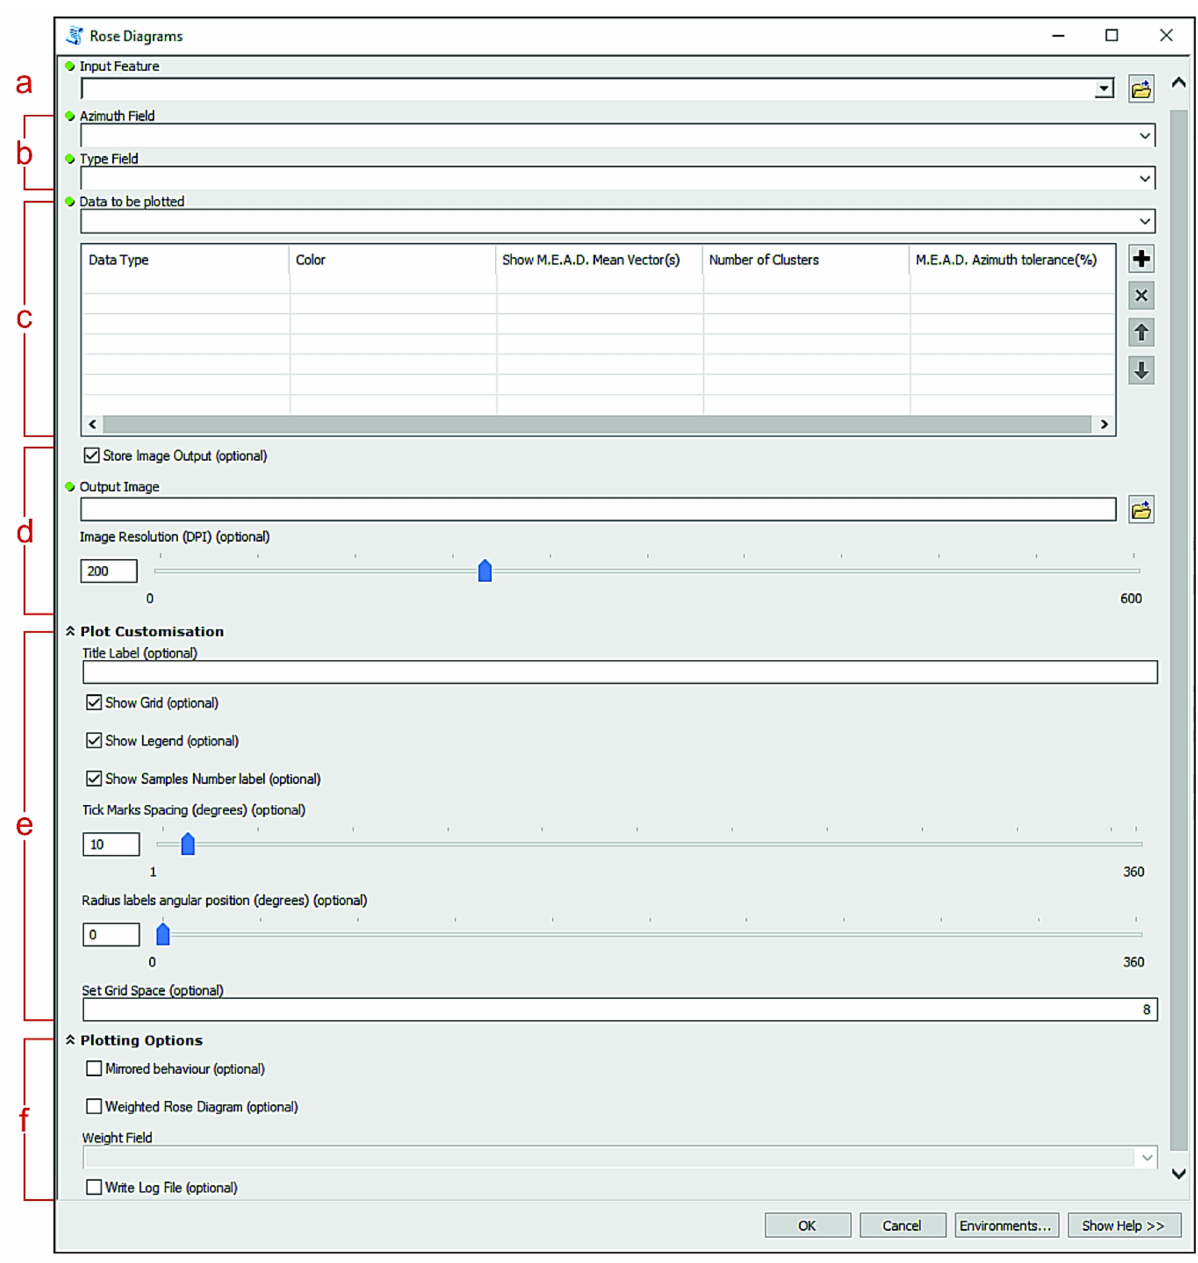
Figure 6. ‘Rose Diagrams’ tool layout. Green dots indicate required parameters. ( a ) Oriented dataset input; requires a shapefile (point, line, and polygon features types are supported). ( b ) Azimuth and Type fields inputs, selectable through the drop-down menus. ( c ) Plotting data Value Table; for each added feature type, the user can specify the bar colour and whether to show the mean vectors or not, with a determined number of clusters and azimuth tolerance. ( d ) Output image settings; the rose diagram can be saved as a temporary file by unchecking the ‘Store Image Output’ option, otherwise an output file path can be selected. ( e ) Plot customisation submenu; rose diagram look can be here customised. ( f ) Plotting options submenu; ‘Mirrored behaviour’ option allows to prompt for a specular rose diagram, ‘Weighted Rose Diagram’ option allows the user to weight data (a weight field must be provided). The ‘Write Log File’ option can be checked to prompt the tool to compile a text file storing statistical information concerning the plotted